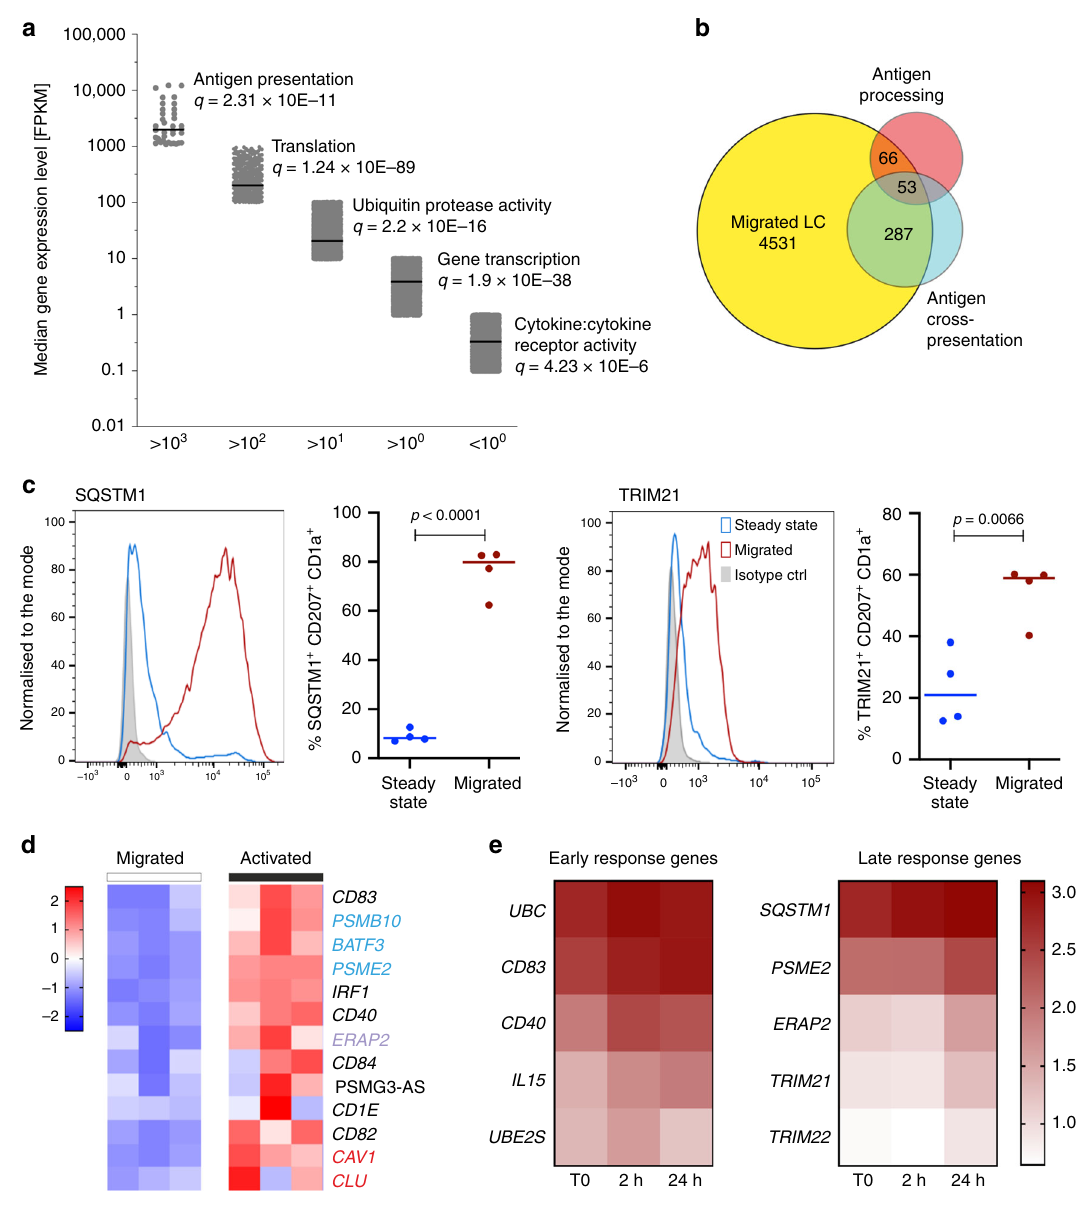
Fig. 2 Transcriptional programming of migrated human LCs. a Dominant biological processes and pathways enriched in genes expressed at varying levels in steady-state migrated LCs. Gene ontology analysis for each expression level (Fragments Per Kilobase of transcript per Million mapped reads, FPKM) interval determined by RNA-seq was performed using ToppGene on-line tool 78 . Line denotes median value in the interval. Top unique Biological processes are shown for each interval, signi fi cance denoted by FDR (Benjamini-Hochberg) corrected P -value is shown. The x -axis shows consecutive cut-offs for each interval in gene expression levels. Source data are provided as a Source Data fi le. b Overlaps between reported cross-presentation (373 genes) and antigen processing (212 genes) signatures, and genes expressed in migrated LC > 10 FPKM. c Intracellular expression of SQSTM1 and TRIM21 measured by fl ow cytometry. Steady-state (blue) and migrated (red) LCs. Representative histograms followed by quantitative analysis n = 4 independent donors, unpaired t test, line denotes median value. Source data are provided as a Source Data fi le. d TNF stimulation (24 h) of human LCs induces genes involved in antigen traf fi cking (red), processing (purple) and cross-presentation (blue). Expression levels of three biological replicates (TMM normalised gene expression levels, scaled in rows). Source data are provided as a Source Data fi le. e Enrichment of immune activation genes upregulated during a time course of TNF stimulation: left: early induced genes, peak expression at 2 h, Cluster 3, right: late induced genes, peak expression at 24 h. Median of three biological replicates, normalised expression levels. Stars denote genes belonging to antigen presentation in class I, MSigBD, Broad Institute. Source data are provided as a Source Data fi le. (Supplementary Data 4). Analysis of H3K27 acetylation peaks in tissue-speci fi c gene expression 57,58 . Thus, we performed ChIP-seq the same LC preparations shows 78% to be shared across all three to analyse the genome-wide landscape of H3K4Me3 and samples (Supplementary Data 5). Of 13,402 H3K4Me3 peaks that H3K27Ac in migrated and TNF-activated LCs. Three indepen- were common to migrated LCs (associated with 11,665 unique dent samples of human migrated LCs exhibited a highly con- genes), over 92% were mapped to promoter regions (Supple- served histone modi fi cation landscape across the genome with mentary Data 4). In contrast, while 62% of H3K27Ac peaks were overlapping H3K4Me3 peaks in 95% of the marked regions NATURE COMMUNICATIONS| (2020) 11:313